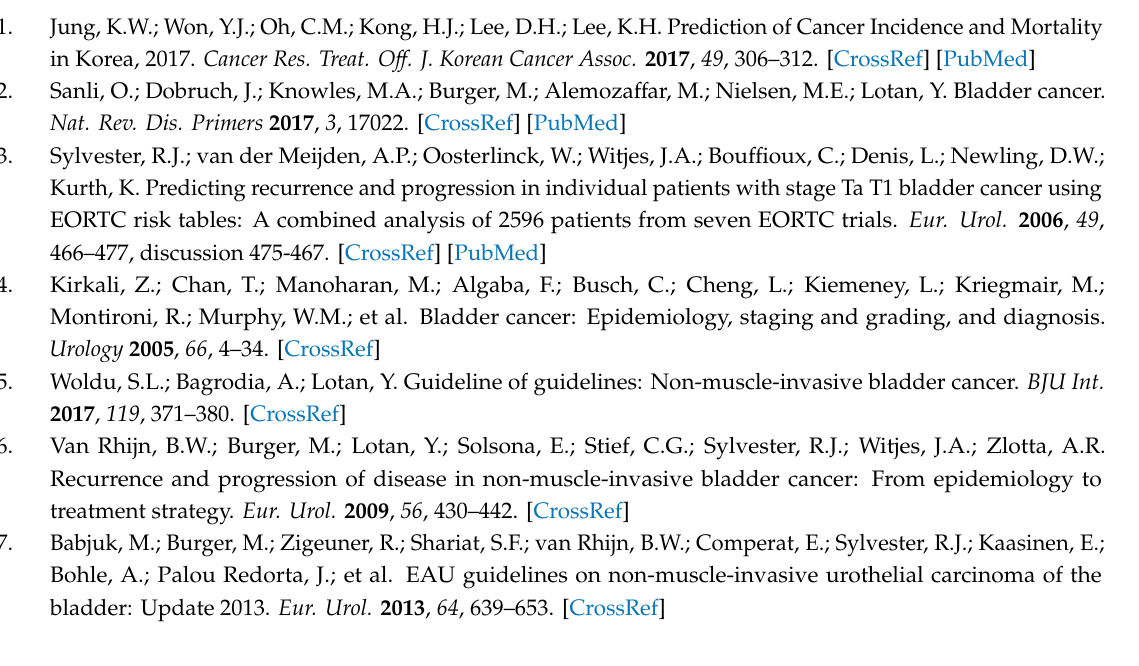
Figure S1: Prognosis according to tumor stage and grade of two subgroups divided by FOXM1 expression in NMIBC patient cohort, Figure S2: Function enrichment test and network analysis, Figure S3: Uncropped blots showing all the western bands in 5637 and KU7 cell lines transfected with siFOXM1, Figure S4: The expression of FOXM1 and FANCD2 on knockdown stable cell lines, Figure S5: Uncropped blots showing all bands for stable knockdown of FOXM1 in KU7 and 5637 cell lines, Figure S6: No significance of the expression of FOXM1 by overexpressed FANCD2, Figure S7: Uncropped blots showing all the western bands in 5637 and KU7 cell lines transfected with pFANCD2 vector or siFANCD2, Figure S8: Uncropped blots showing all the western bands in 5637 and KU7 cell lines transfected with siFOXM1, treated to MMC, Figure S9: Increased cell viability due to overexpression of pFANCD2 in shFOXM1 cells, Table S1: Significantly enriched functions and their involved genes, Table S2: qPCR and plasmid construction primer